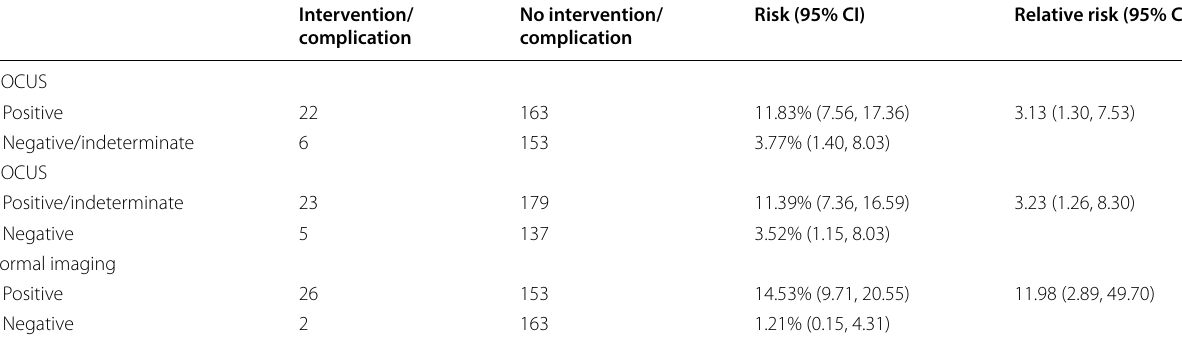
Table 4 Intervention/complication for POCUS and formal imaging